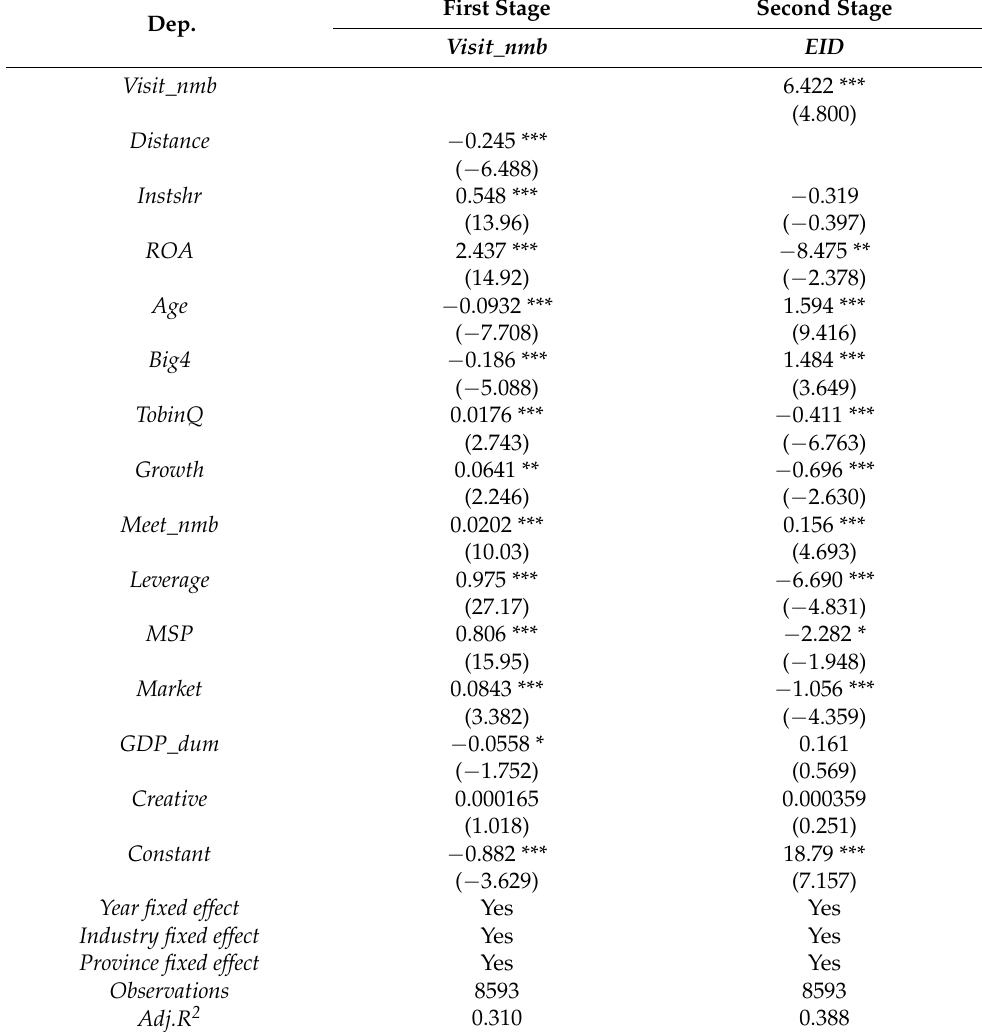
Table 7. Two-stage regression results based on the instrumental variable method.